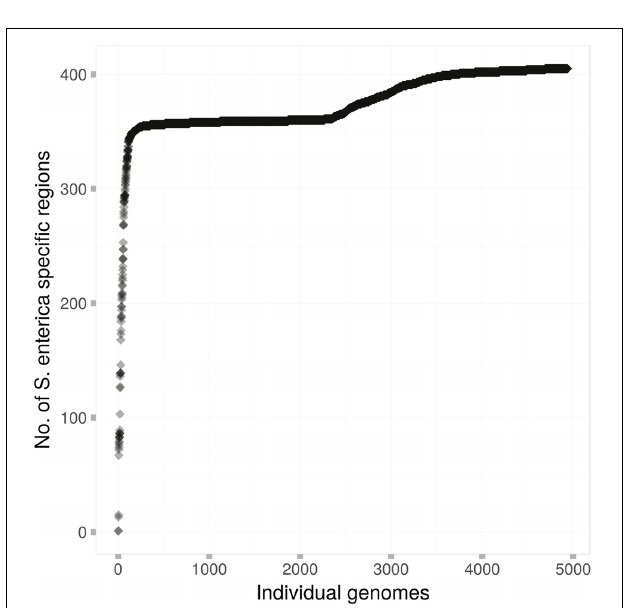
FIGURE 2 | The carriage of the 404 S. enterica species-specific regions among each of the 4939 genomes of this study. Each dot represents a single S. enterica genome, which are arranged in order from those that contain the fewest species-specific regions to those that contain the